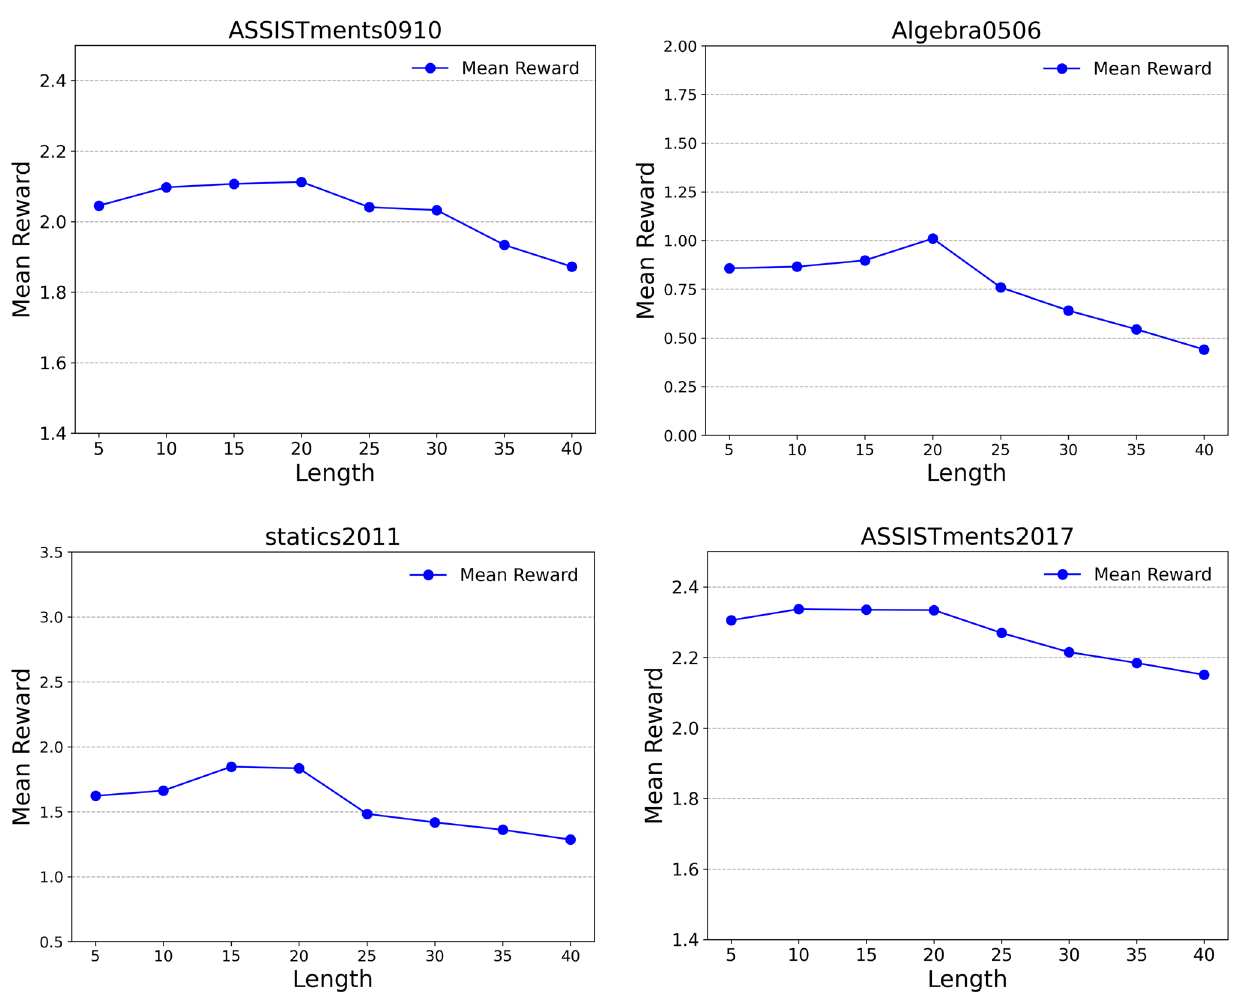
Fig. 14 Effect of the recommended length for different